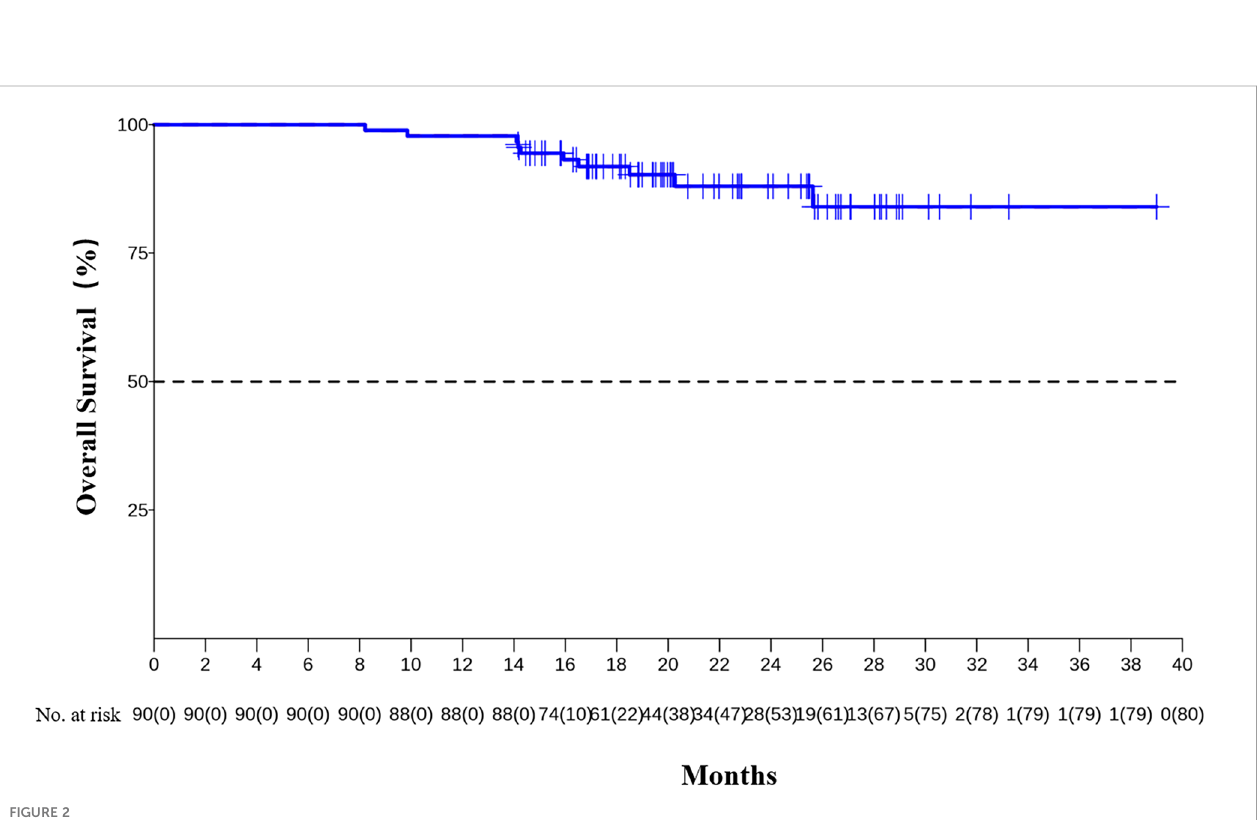
FIGURE 2 Kaplan-Meier estimates of